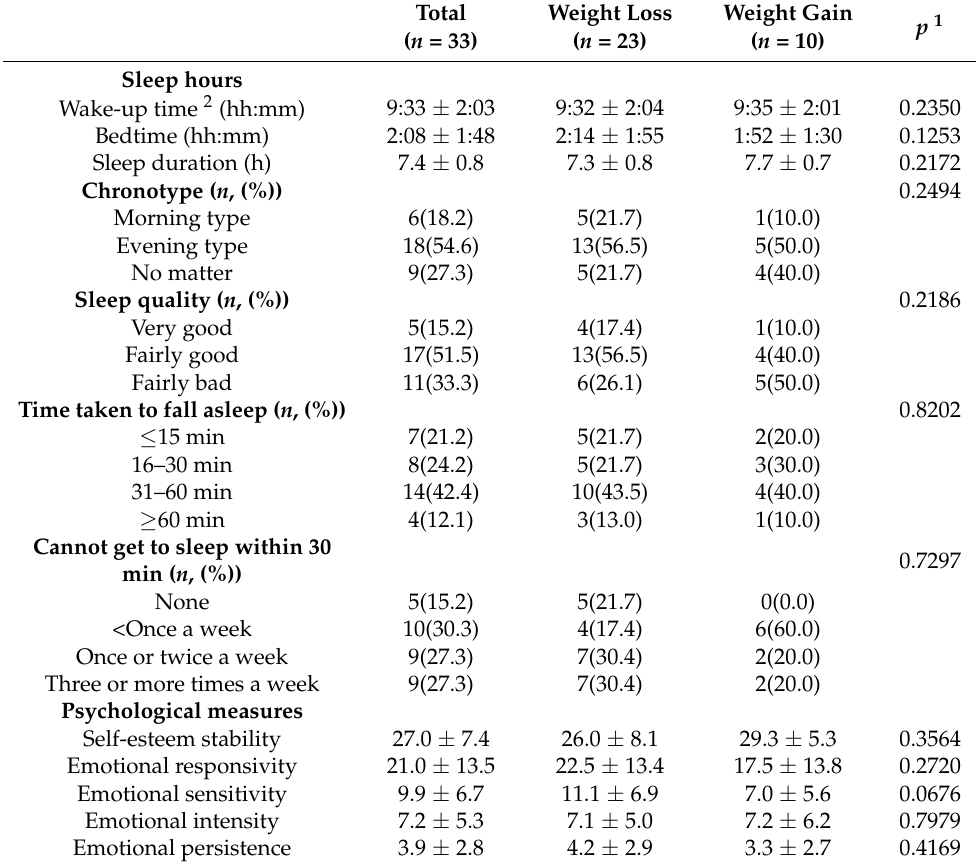
Table 4. Sleep and psychological characteristics of participants during 4 weeks of time-restricted eating.